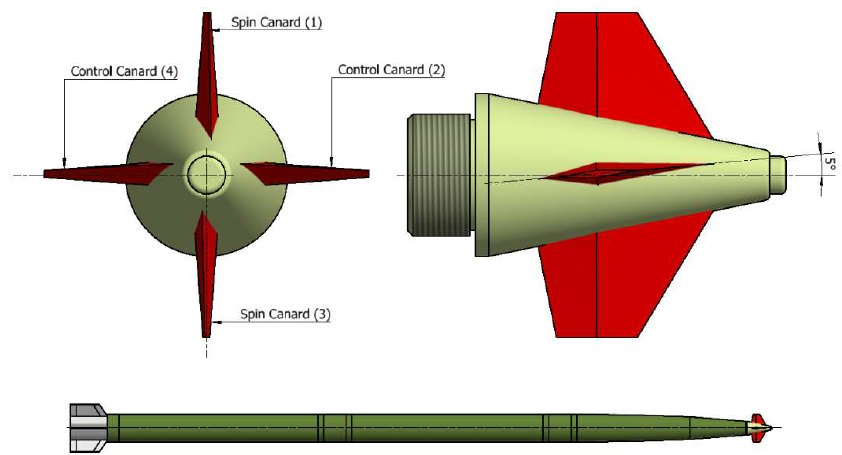
Figure 1. Correction Fuze Configuration on Rocket.